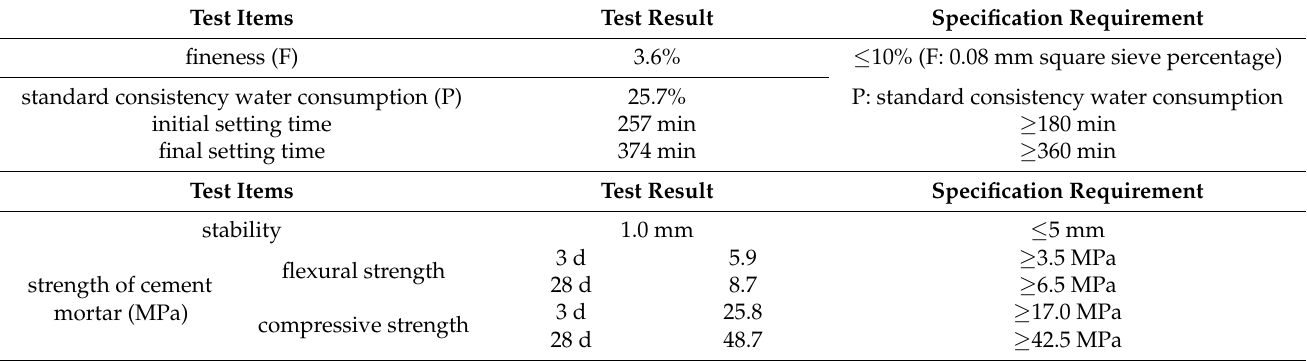
Table 2. Test results of cement performance.